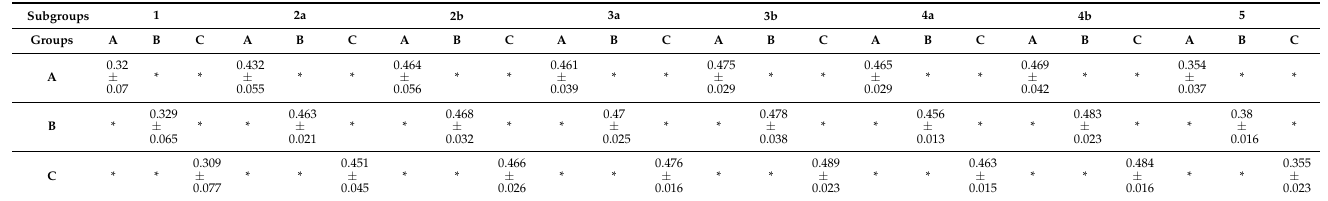
Table 3. Statistical differences between study subgroups in groups A, B, and C. Group